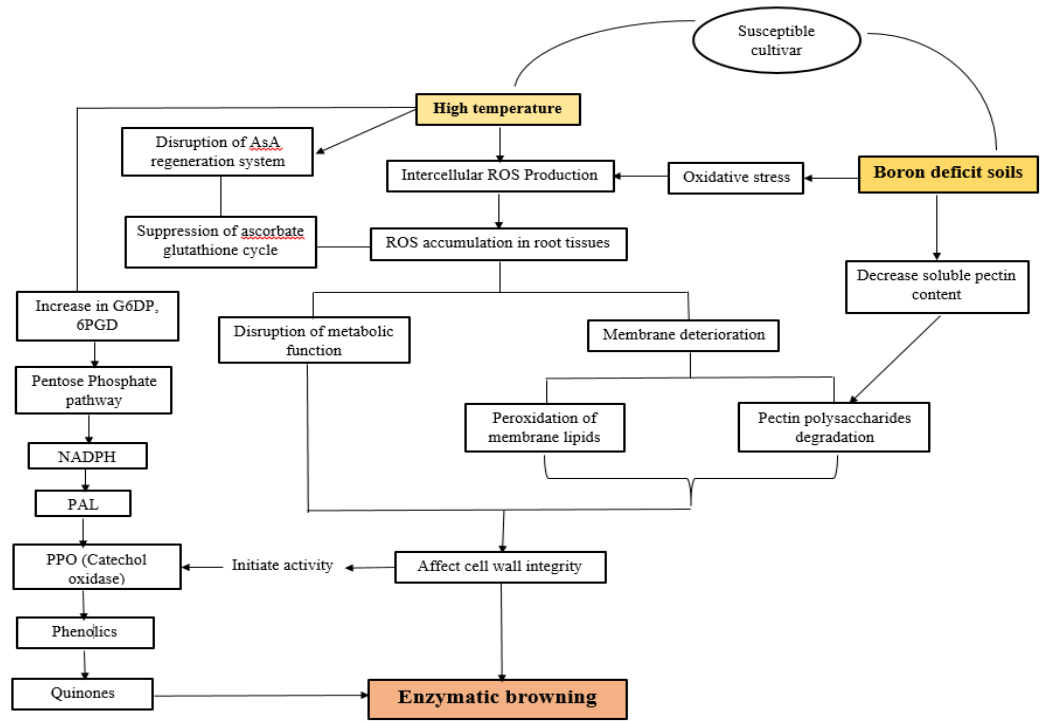
Figure 6. Brown heart/internal browning disorder in susceptible cultivars of radish is due to oxidation (enzymatic) of phe- nolic compounds and it occurs mainly by two important factors. (1) Low boron concentration in soil. (2) High